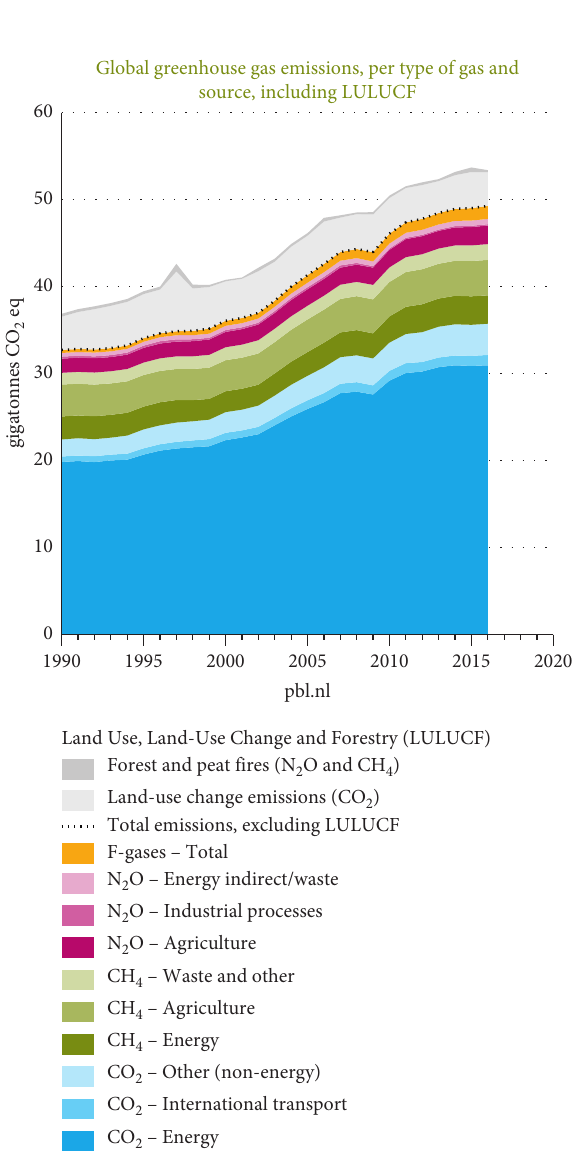
Figure 2: Global greenhouse gas emissions, per type of gas and source, including LULUCF (source with permission: Olivier and Peters [22], Trends in global CO 2 and total greenhouse gas emissions: 2019 report, PBL Netherlands Environmental Assess- ment Agency, The